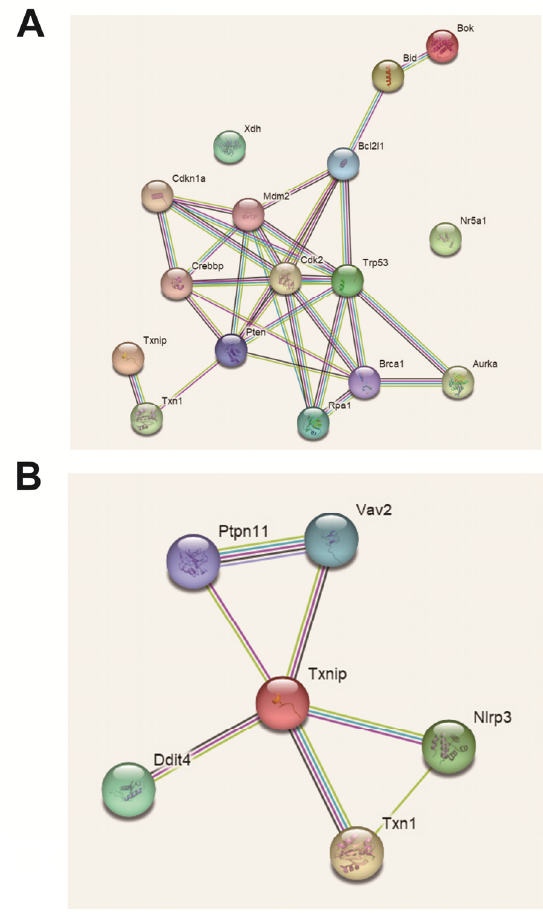
Figure 11. Differentially expressed protein interaction visualization (PPI) map. ( A ) Personalized analysis of differentially expressed protein interactions. ( B ) Personalized analysis of key protein interactions.